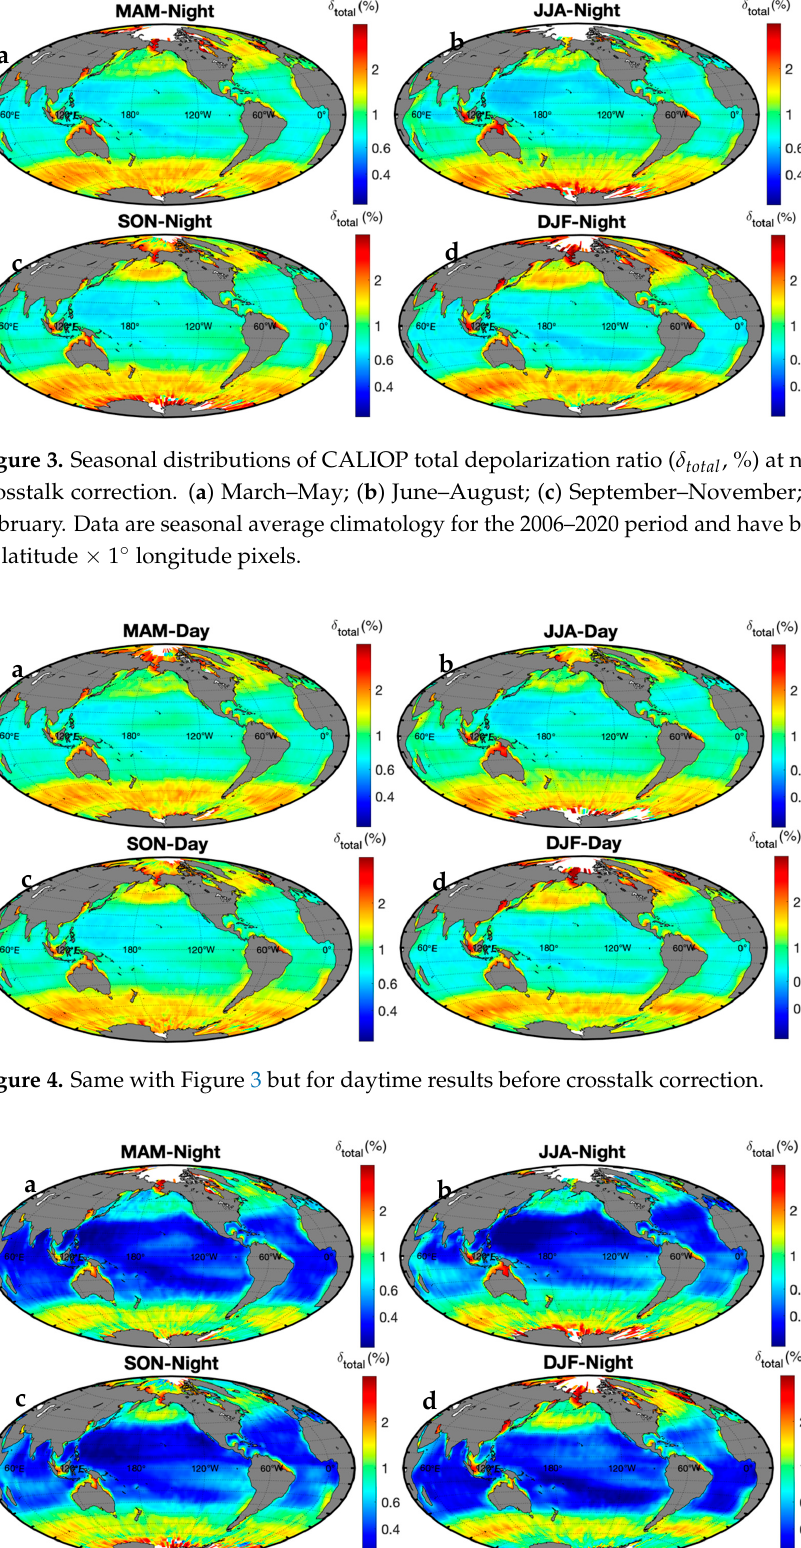
Figure 5. Seasonal distributions of CALIOP total depolarization ratio ( δ total , %) at nighttime after crosstalk correction. ( a ) March–May; ( b ) June–August; ( c ) September–November; ( d ) December– February. Data are seasonal average climatology for the 2008–2020 period and have been averaged to 1° latitude × 1° longitude pixels.